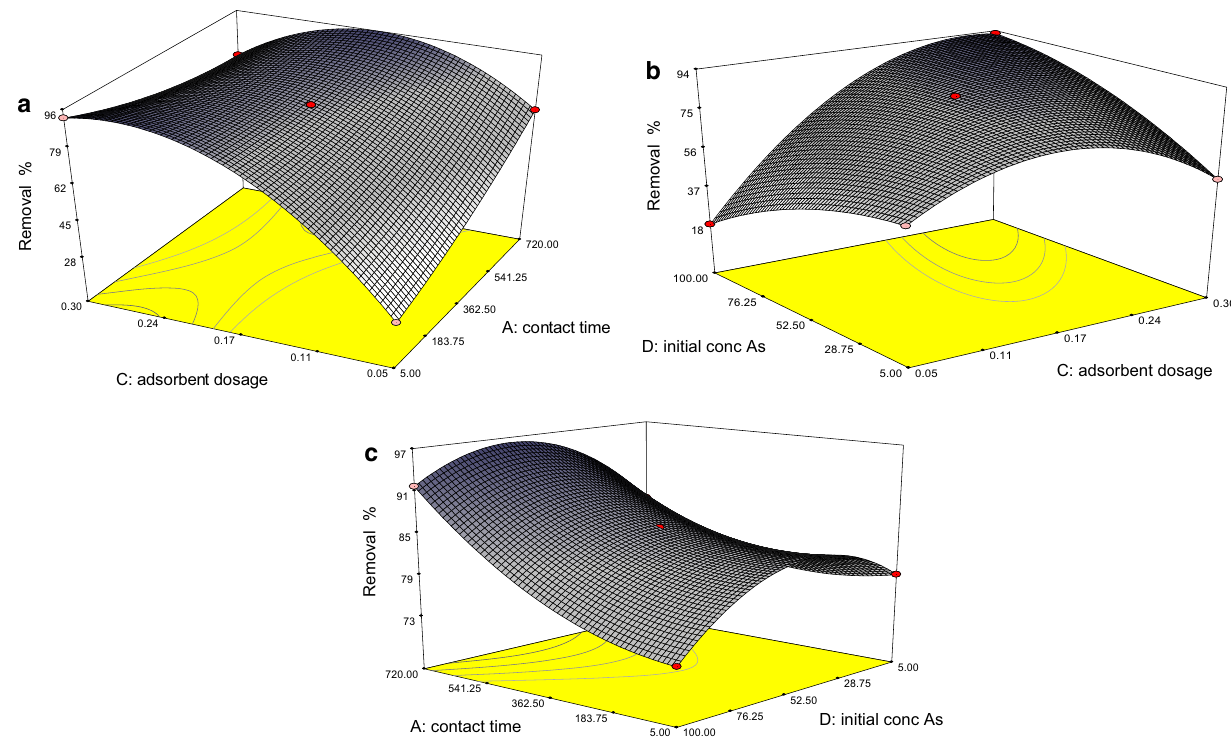
Fig. 4 3D response surface plots for As(III) removal vs a contact time (5–720 min) and adsorbent dose (0.05–0.3 g); b initial As(III) concentration (5–100 l g L - 1 ) and adsorbent dose (0.05–0.3 g); c initial As(III) concentration (5–100 l g L - 1 ) and contact time (5–720 min) Table 6 Optimal condition and model validation for As(III) removal by MPKSF